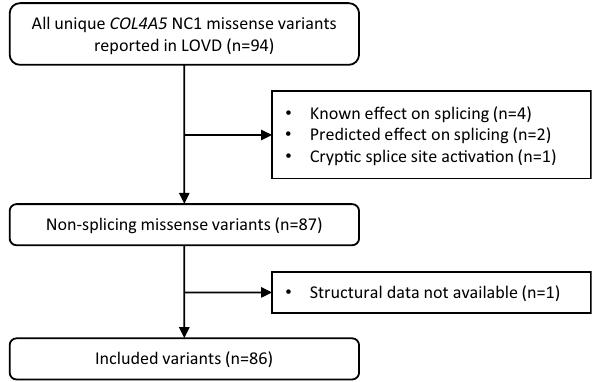
Figure 2. Variant inclusion flowchart for the LOVD study cohort. Counts refer to the number of unique missense variants.